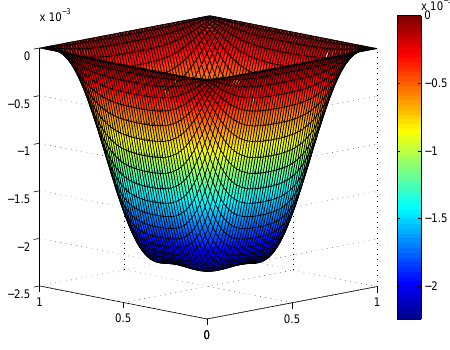
Figure 3. The numerical solution u h with κ = 10 4 .